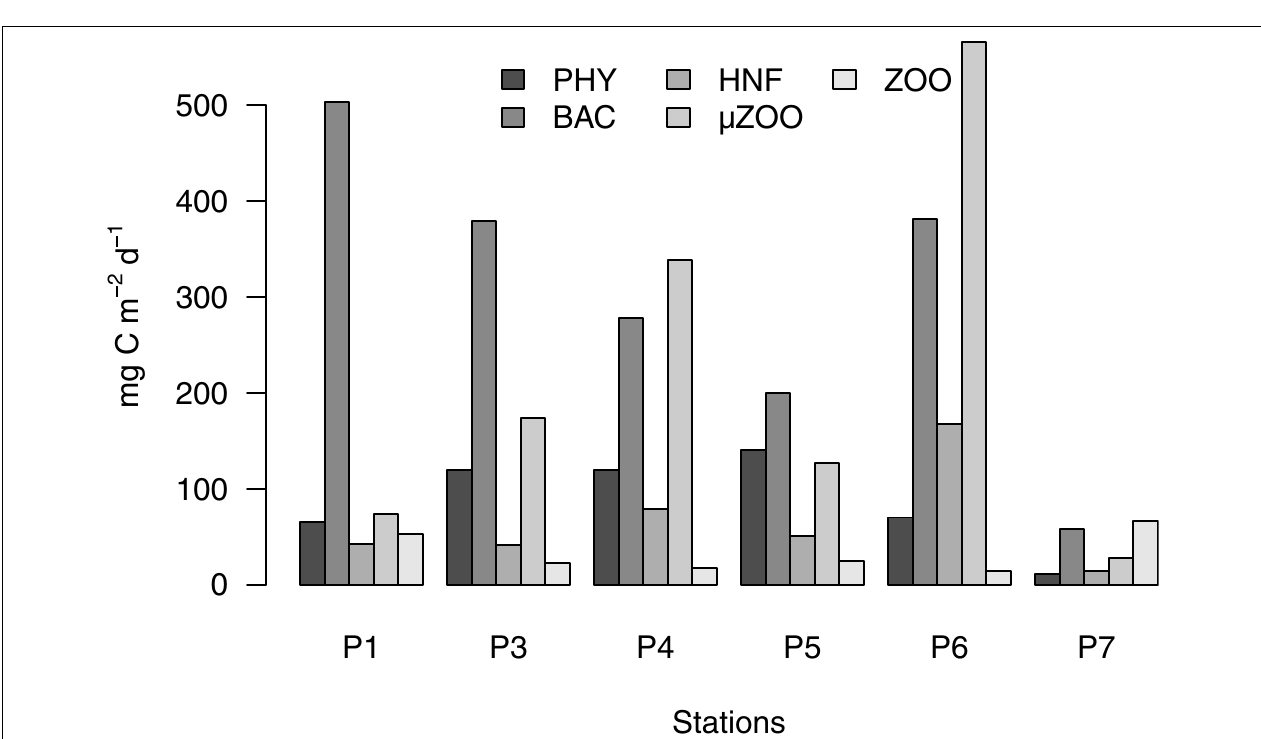
FIGURE 5 | Partitioning of the community respiration flows. Note that all phototrophs and pooled into PHY, and the two mesozooplankton size classes into ZOO.